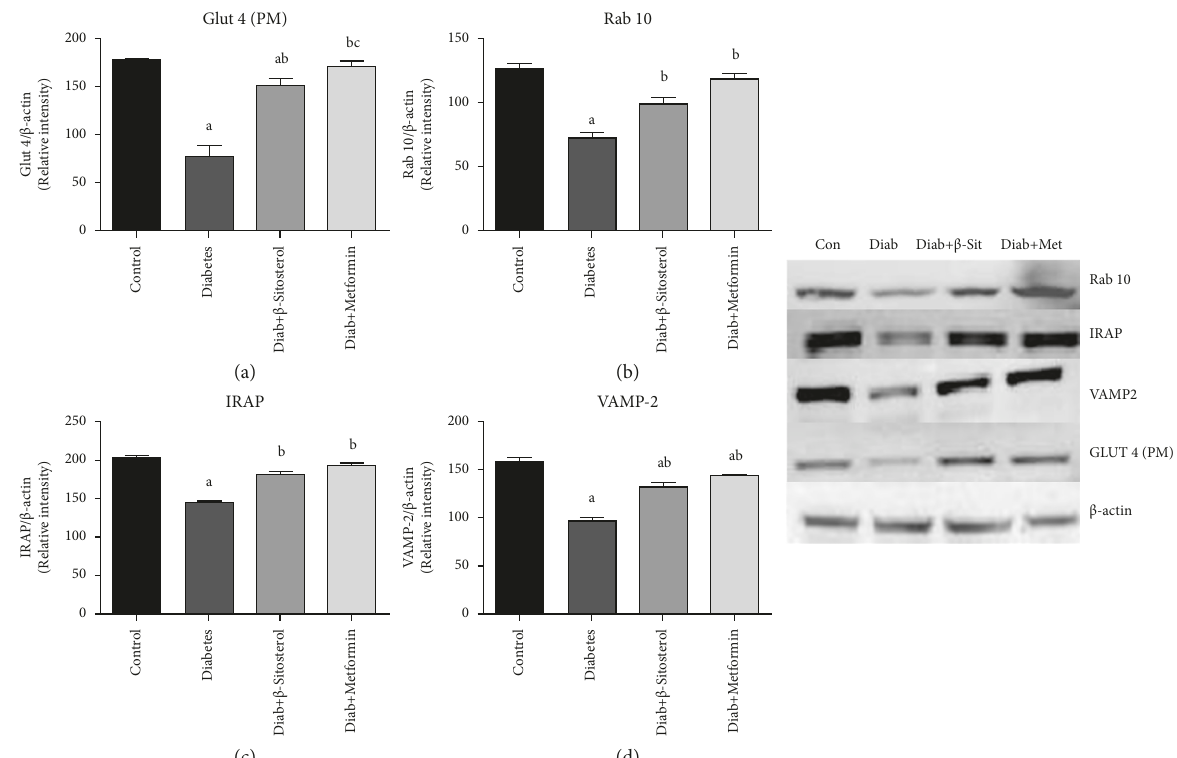
Figure 10: (a–d). Effect of β -sitosterol on the concentration of GLUT4, Rab10, IRAP, and VAMP-2 proteins in diet-induced diabetic rats was chalked out by western blotting. β -actin was kept as a loading control. Mean ± SEM of 6 animals was represented in each bar. The values, which were significant ( p < 0 . 05), were compared with a—control, b—diabetic control, and c —β -sitosterol-treated diabetic group. (a) Glut 4 (PM). (b) Rab 10. (c) IRAP. (d)